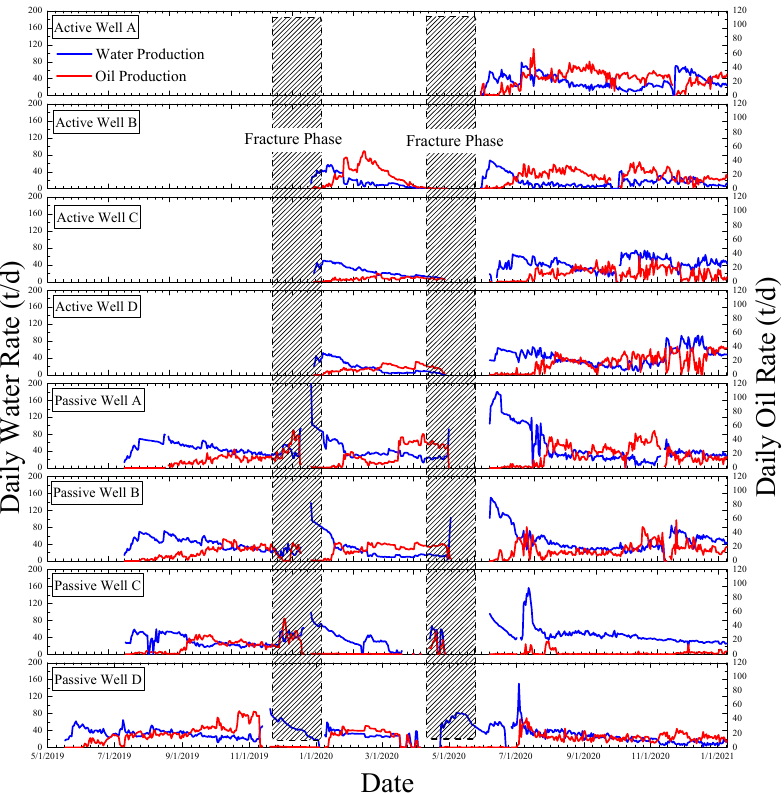
Figure 2. Typical responses of active/passive wells to FDIs in the Mahu 131 block.